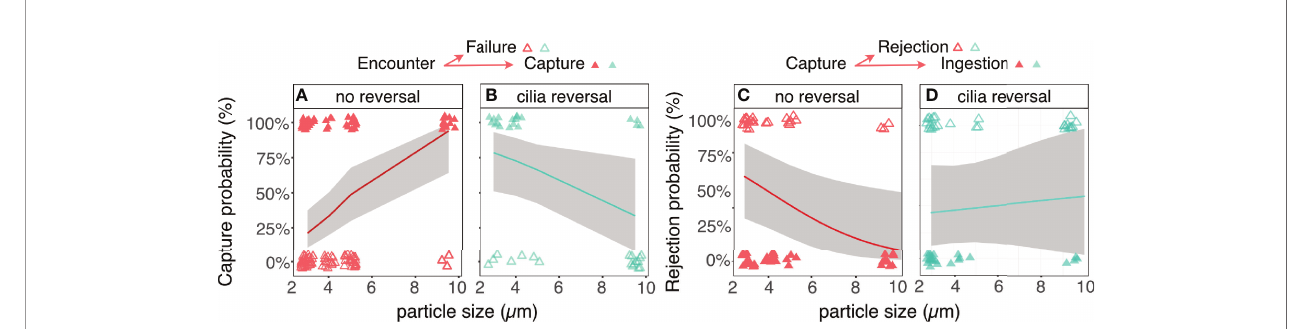
FIGURE 8 | Cilia reversal modi fi es the patterns of prey size selectivity at the stages of capture and handling. Upon encounter, large particles are preferentially captured at the absence of fl ow reversal (A) , but ciliary reversal transposes this trend (B) ( SEM Table 6 ). A similar trend if observed at the handling stage, where larger particles have a lower rejection probability at the absence of fl ow reversal (C) , while ciliary reversal leads to a lower probability to reject smaller ones (D) ( SEM Table 7 ). The size distribution of the ingested prey ( Figure 5 ) are therefore strongly affected by the tintinnid ’ s behavior at the stages of capture and handling. Open triangles denote a negative outcome (particles not captured/rejected), while closed triangles denote a positive outcome (particles captured/not rejected). Red triangles denote capture events without ciliary reversal while green ones denote reversal. Lines and shaded areas are the logit function depicting the probability of capture of rejection (± CI) for a given particle size/aspect ratio from a